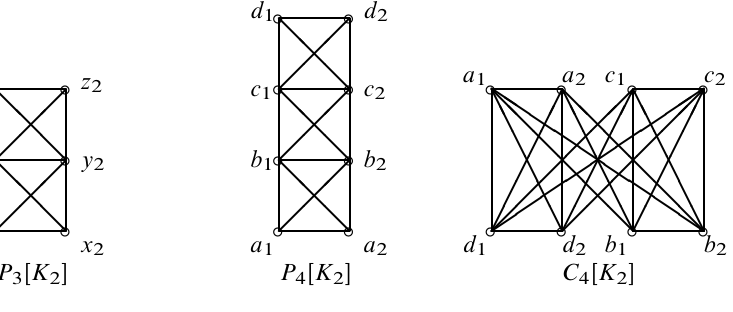
Fig.3. Graphs P 3 ŒK 2 (cid:141) , P 4 ŒK 2 (cid:141) and C 4 ŒK 2